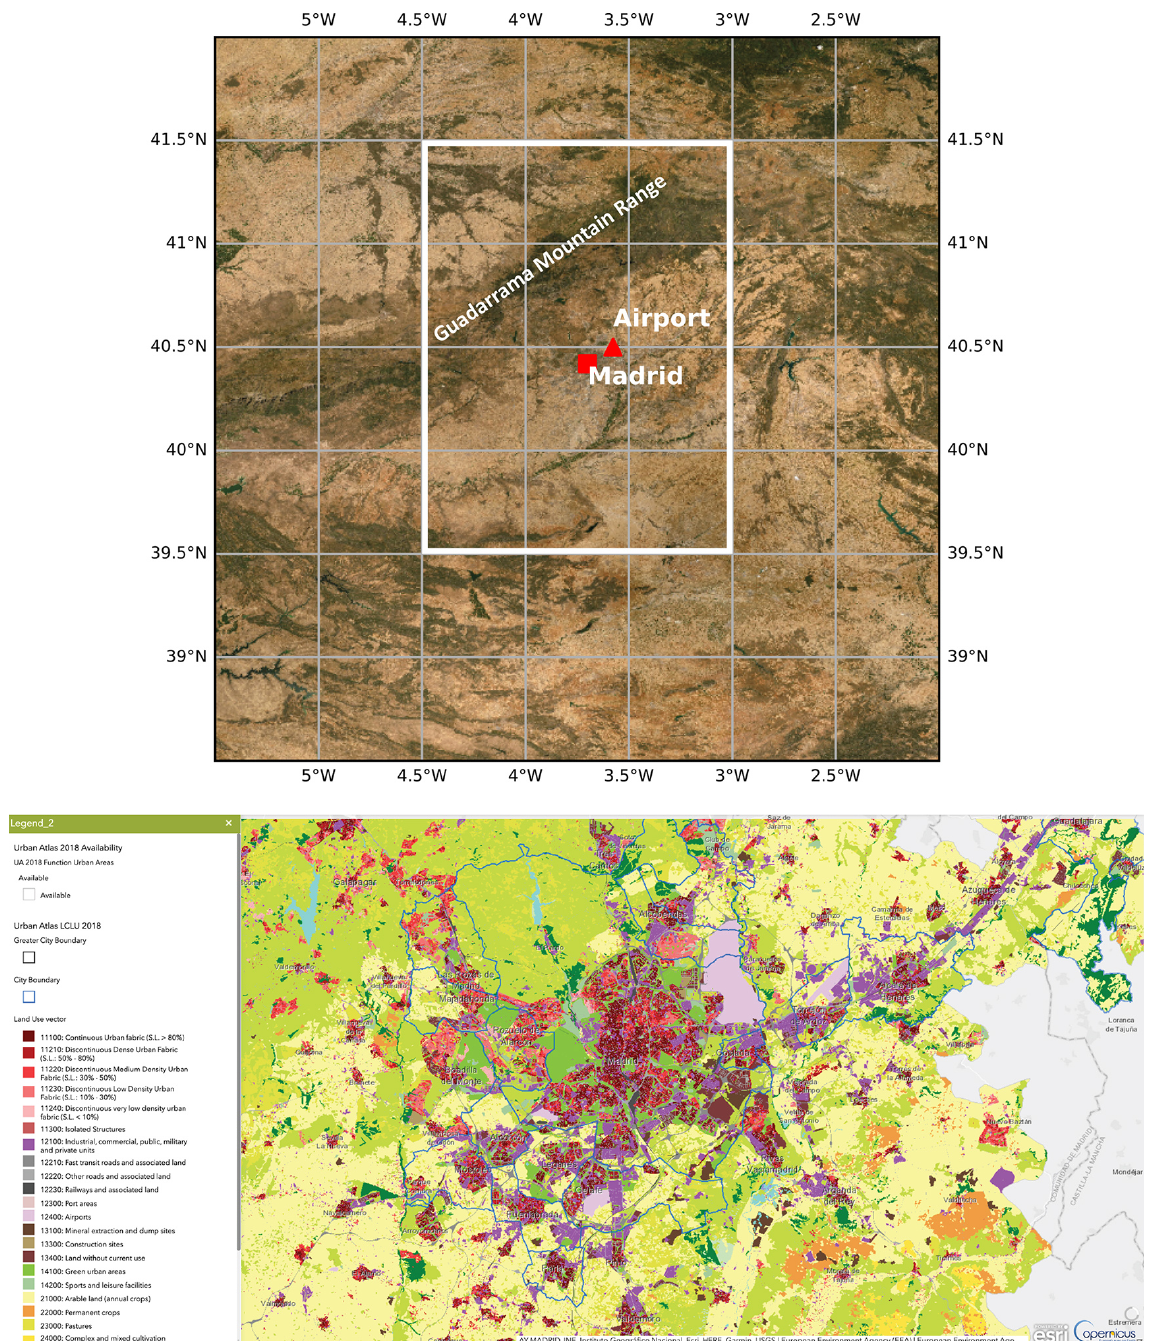
Figure A10. Map of the study area (top; © Esri) and a zoomed-in version (bottom; https://land.copernicus.eu/local/urban-atlas/ urban-atlas-2018, last access: 25 April 2022) for